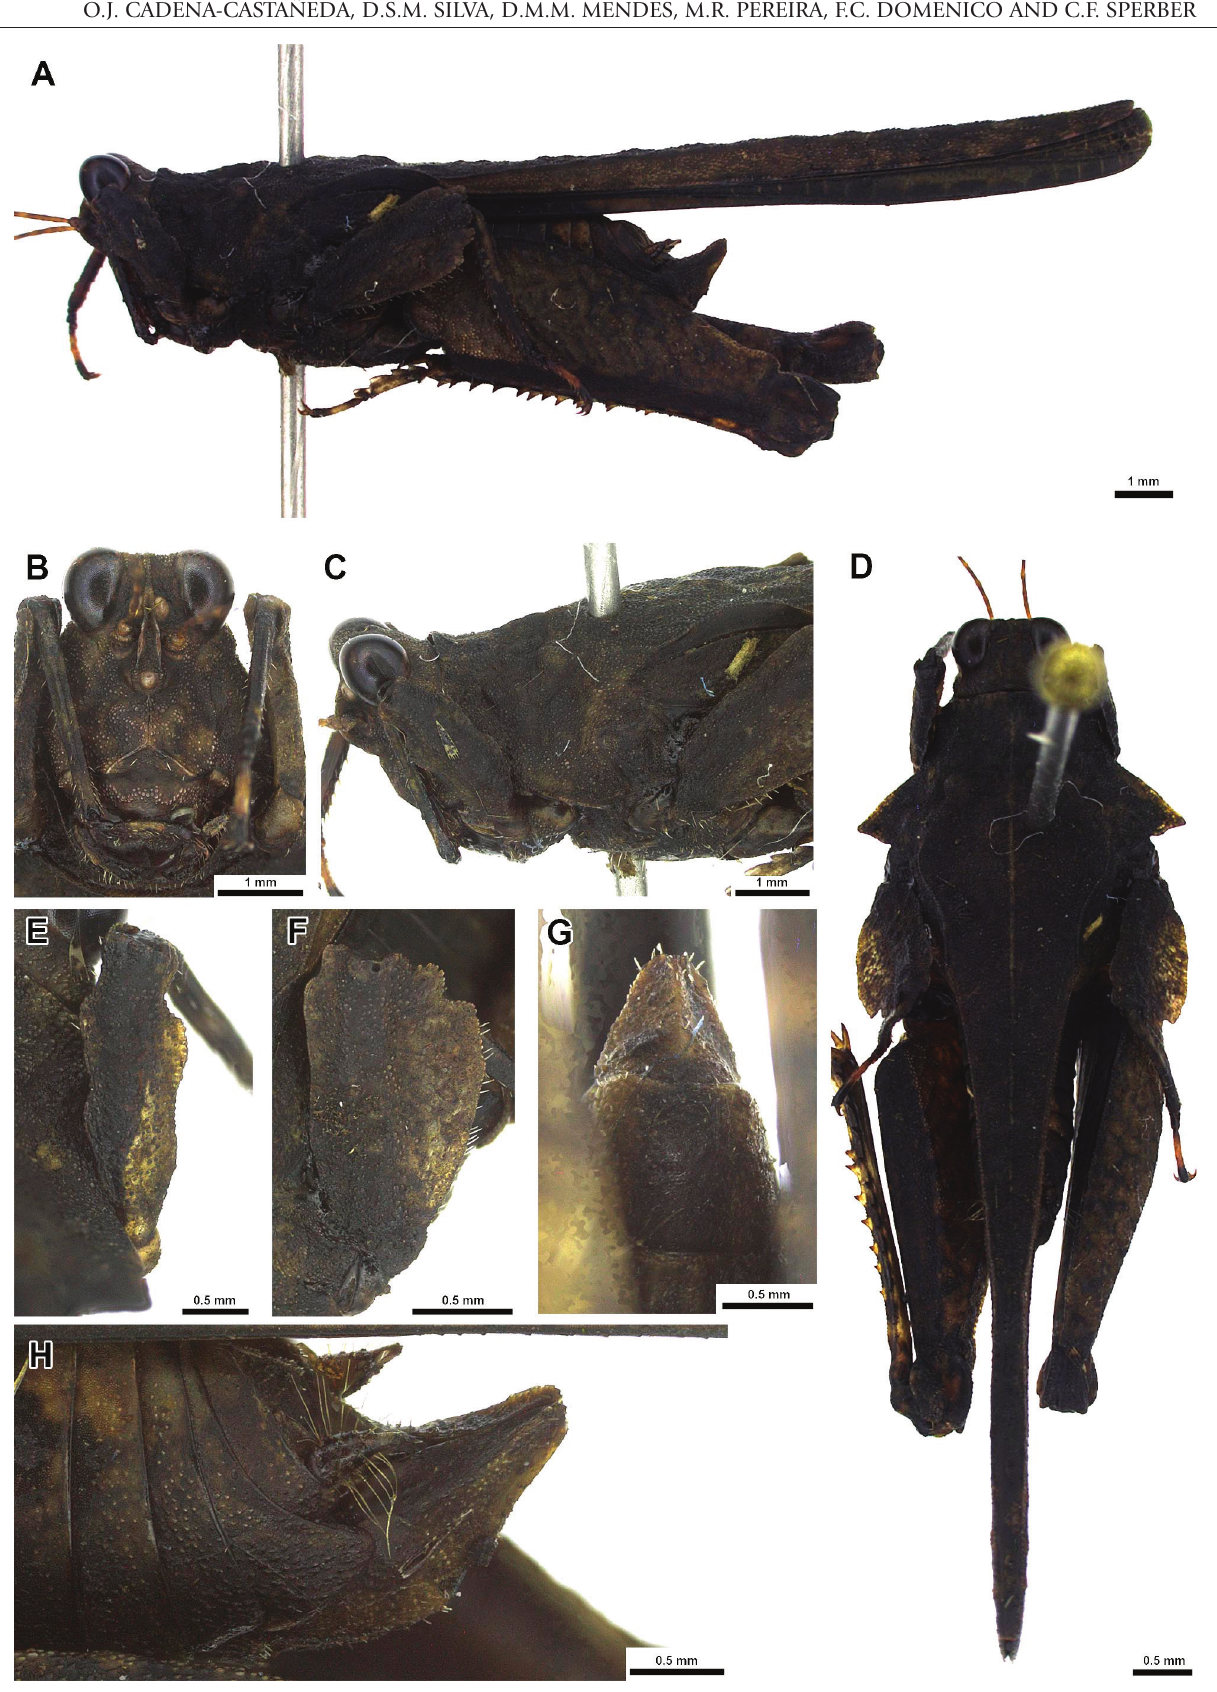
Fig. 6. Eomorphopus granulatus (male not a type) A. Habitus in lateral view; B. Frons; C. Head, lateral lobes of pronotum and tegmina in lateral view; D. Habitus in dorsal view; E. Fore-femur; F. Mid-femur; G. Terminalia in ventral view; and H. In lateral